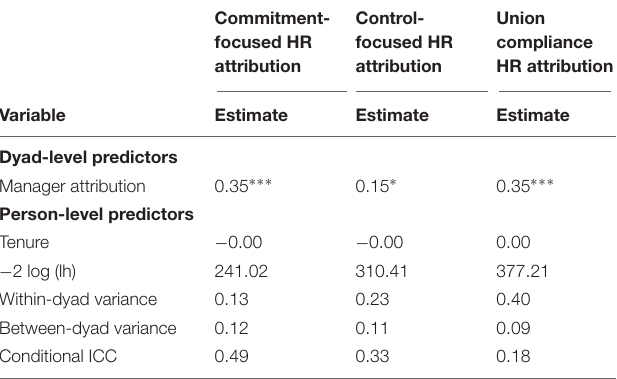
TABLE 2 | Multilevel estimates for predicting employee HR attributions.